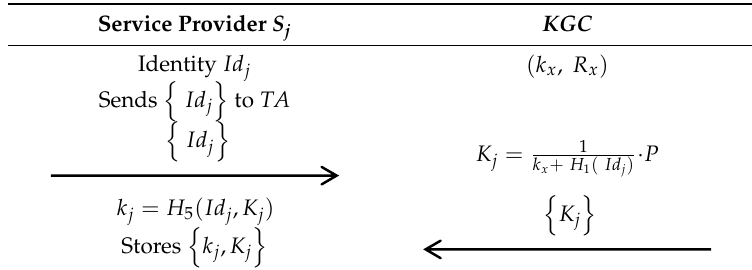
Table 3. Registration phase of service provider in Odelu’s scheme.